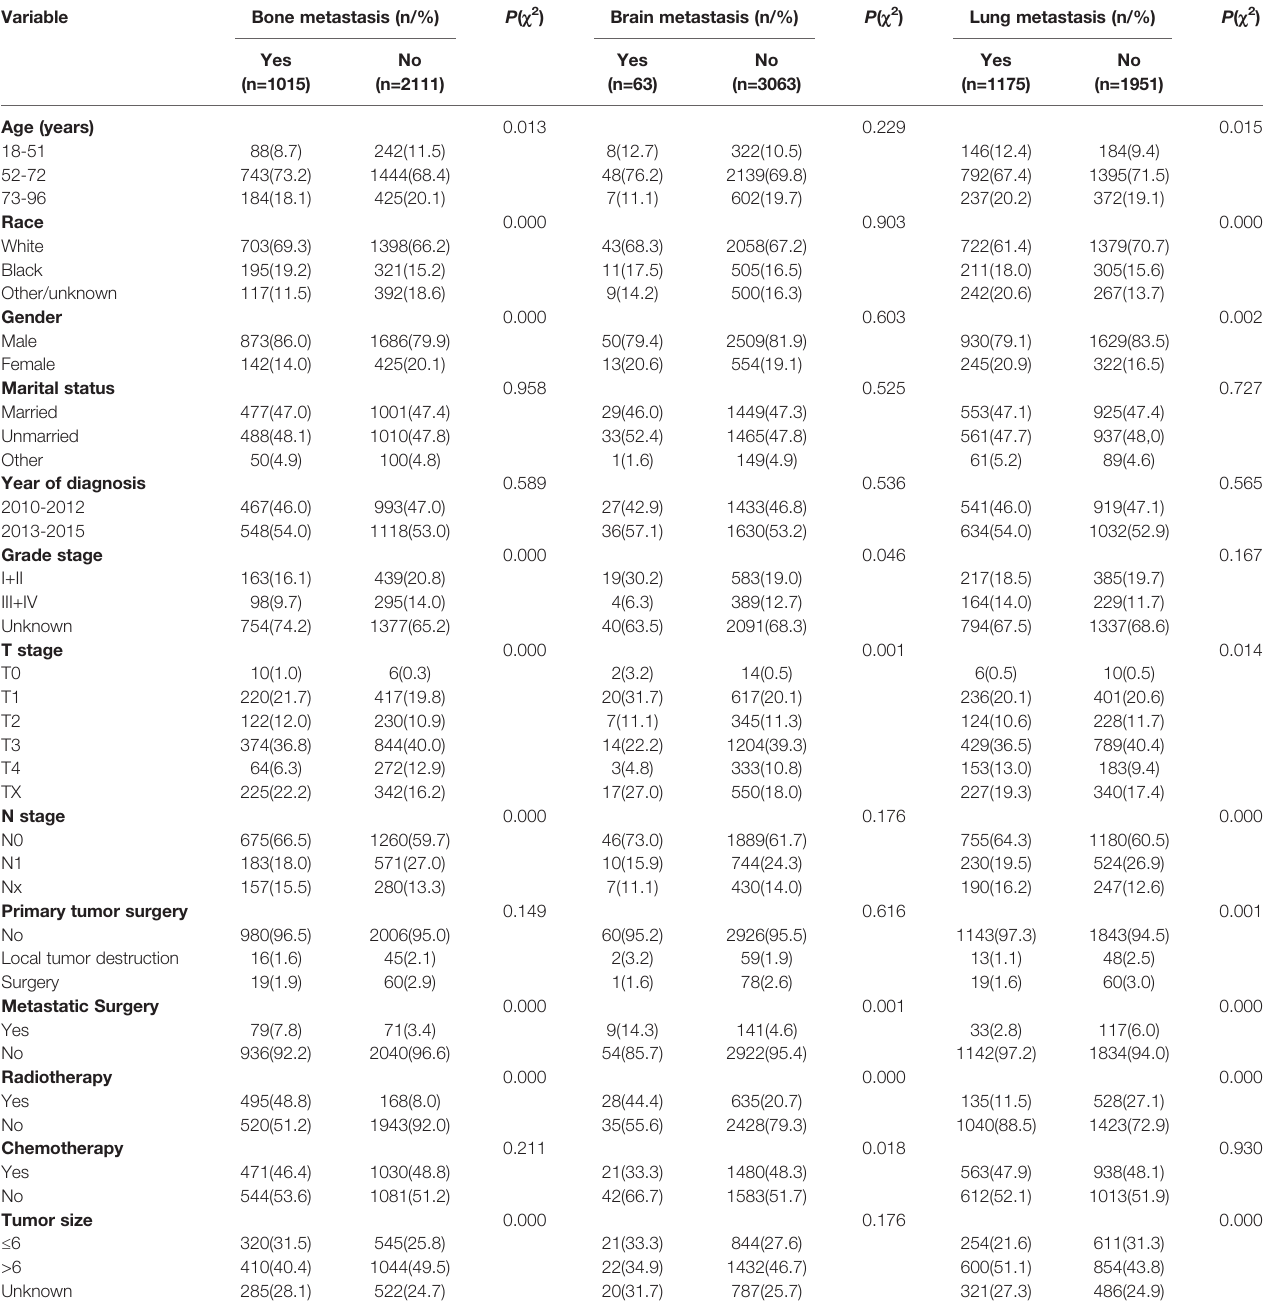
TABLE 1 | The relationship between different metastatic sites and clinical features. Variable Bone metastasis